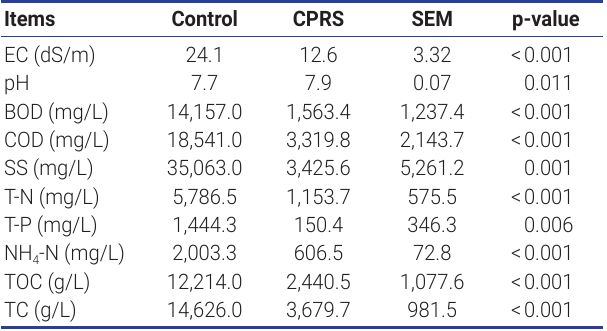
Table 2. Comparison of chemical properties of slurry pit manure ac- cording to the application of a continuous pit recirculation system in the finishing pig